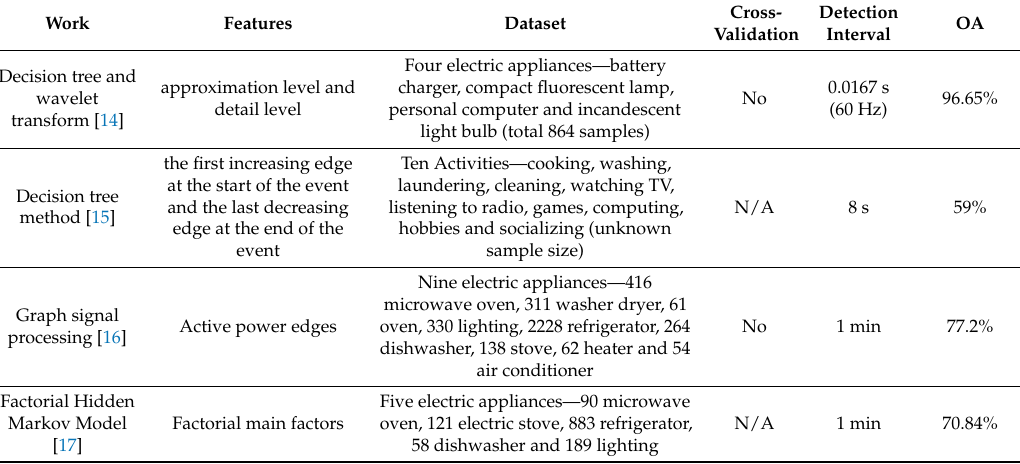
Table 6. Performance comparisons between GA-SVM-MKL and related